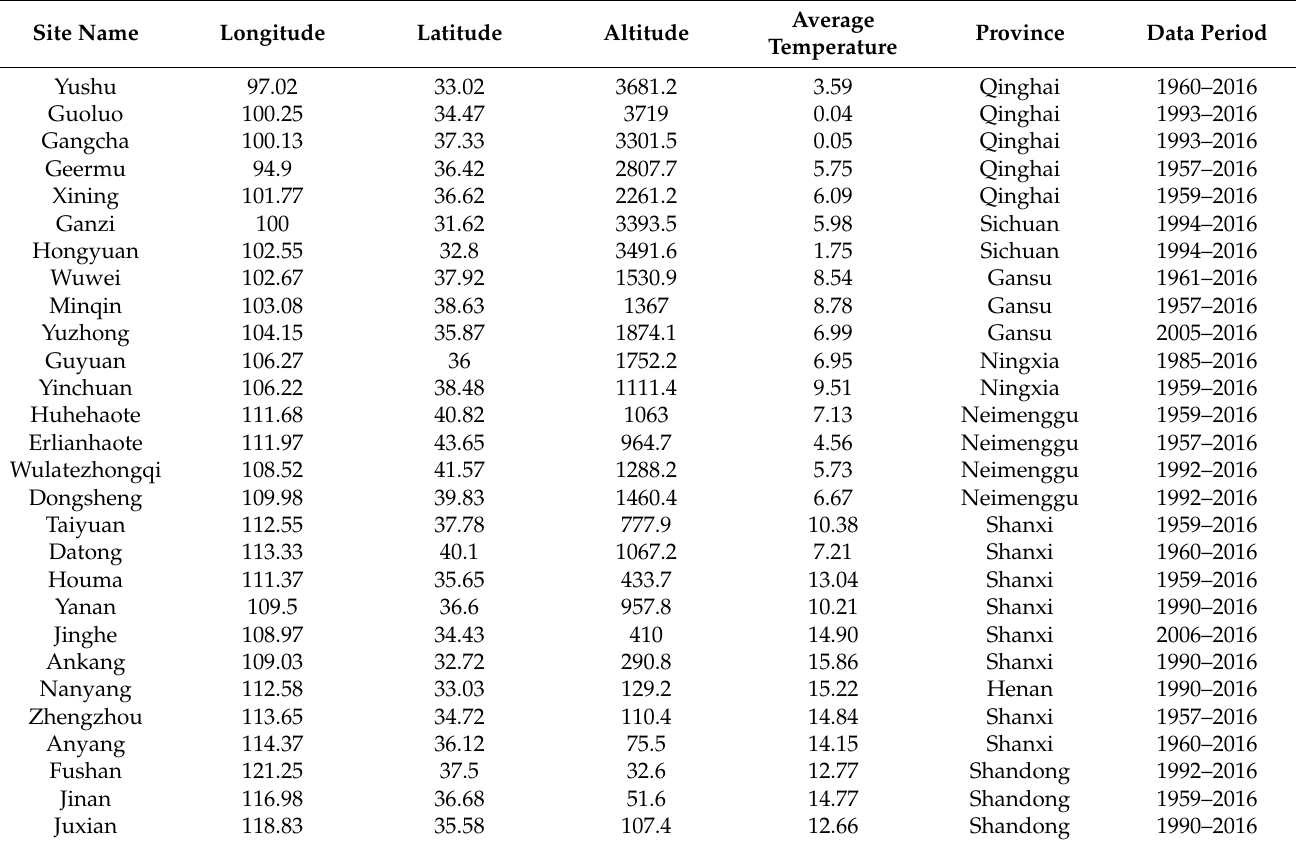
Table 1. Basic information of stations in the Yellow River